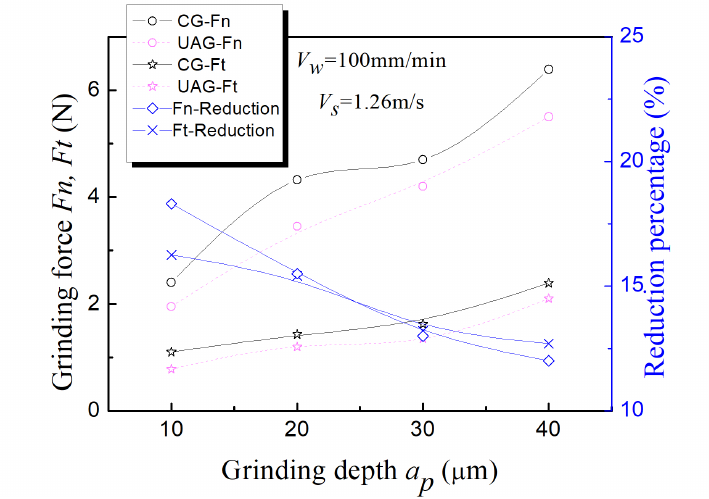
Figure 7. Side grinding: the influence of grinding depth changes on the grinding force.